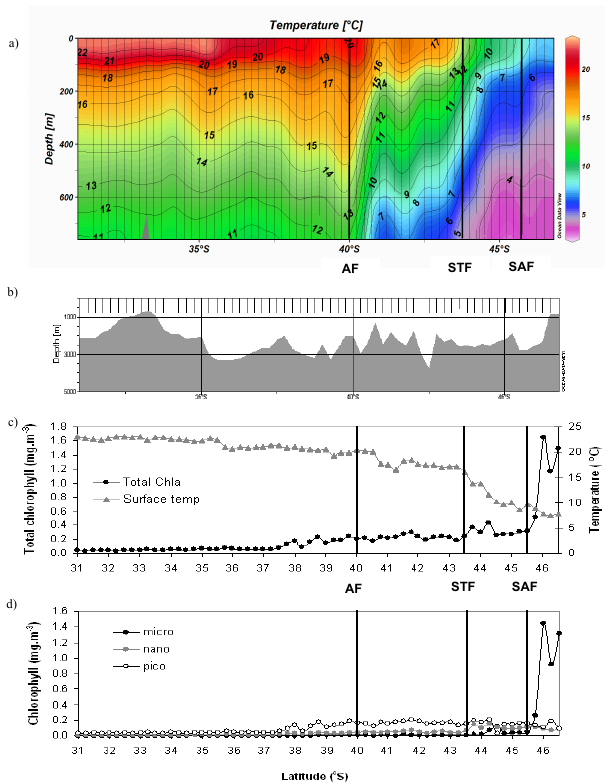
Fig. 2. (a) XBT temperature section during the Northbound Tran- sect, data points for all XBT stations are marked and appear as ver- tical lines on the temperature section, (b) topography section shows the position and depth of each XBT station, (c) surface chlorophyll (mgm − 3 ) and sea surface temperature ( ◦ C) distribution and (d) size fractionated distribution (mgm − 3 ) of surface chlorophyll along the Northbound Transect. The position of the Agulhas Front (AF), Sub- tropical Front (STF) and Subantarctic Front (SAF) are indicated as bold lines. Plots made using Ocean Data View (Schlitzer,